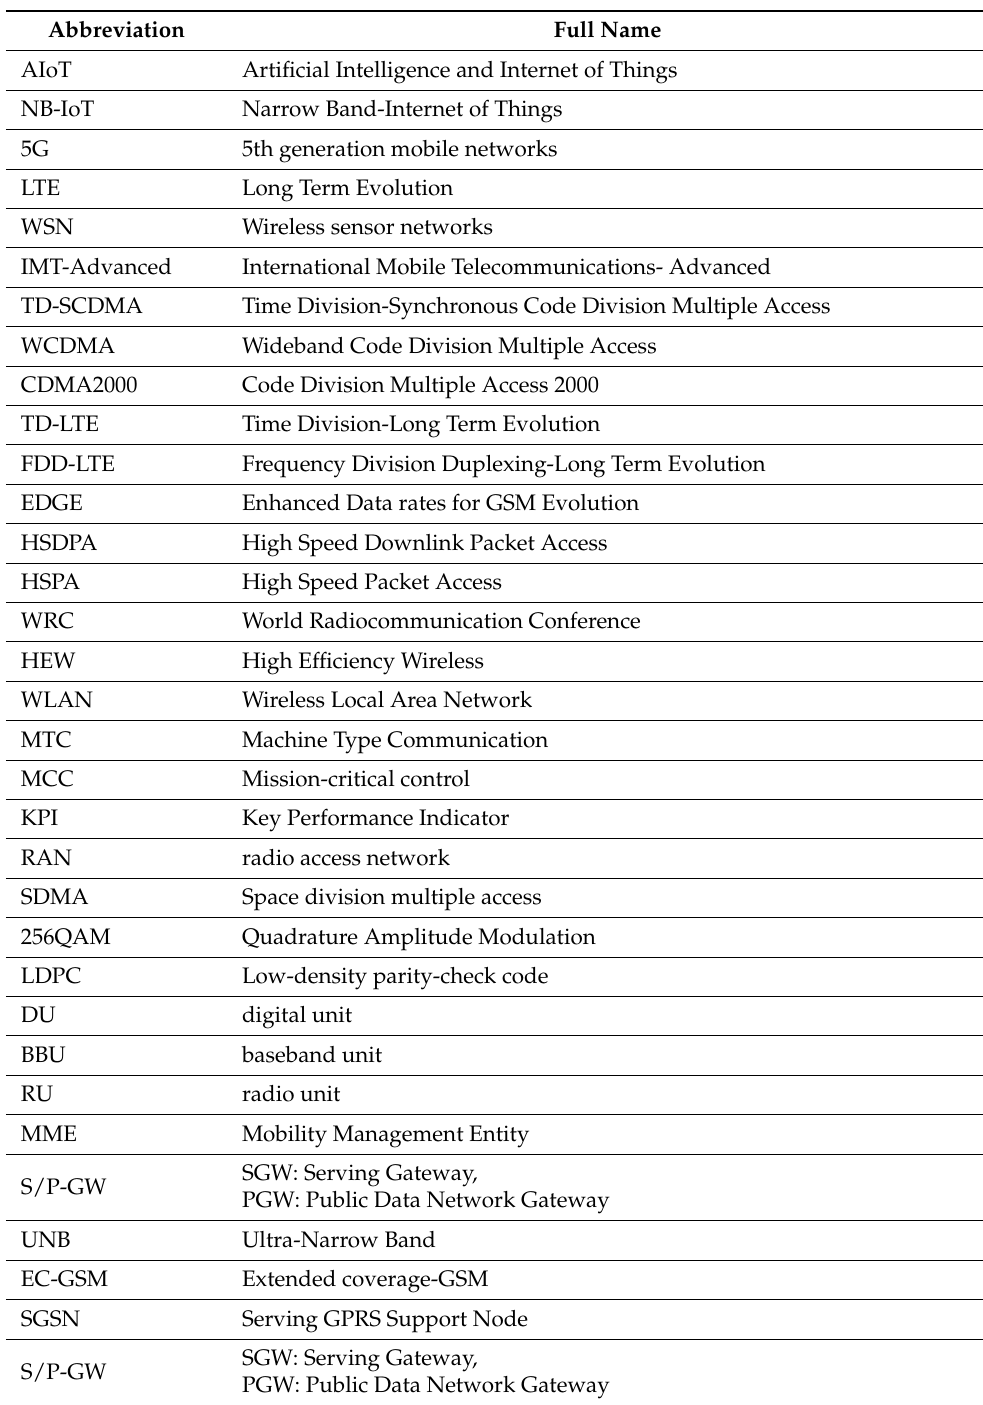
Table 1. Abbreviated terms used in this paper are compared with full